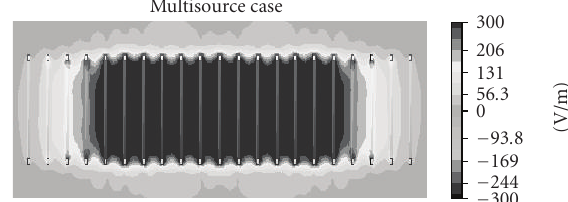
Figure 12: Distribution in the multisource case.